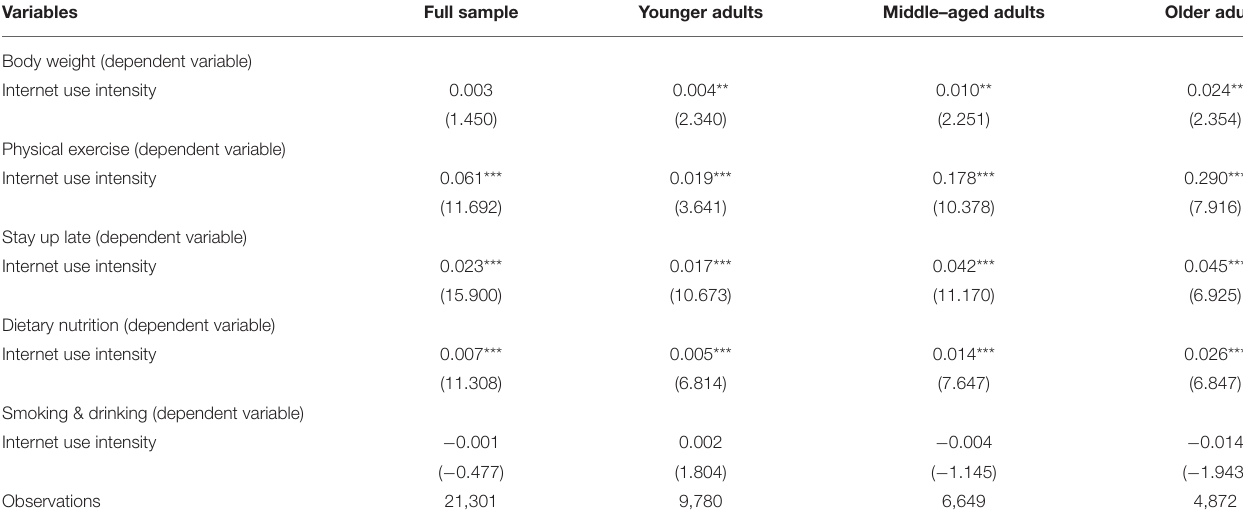
TABLE 8 | Results of robustness